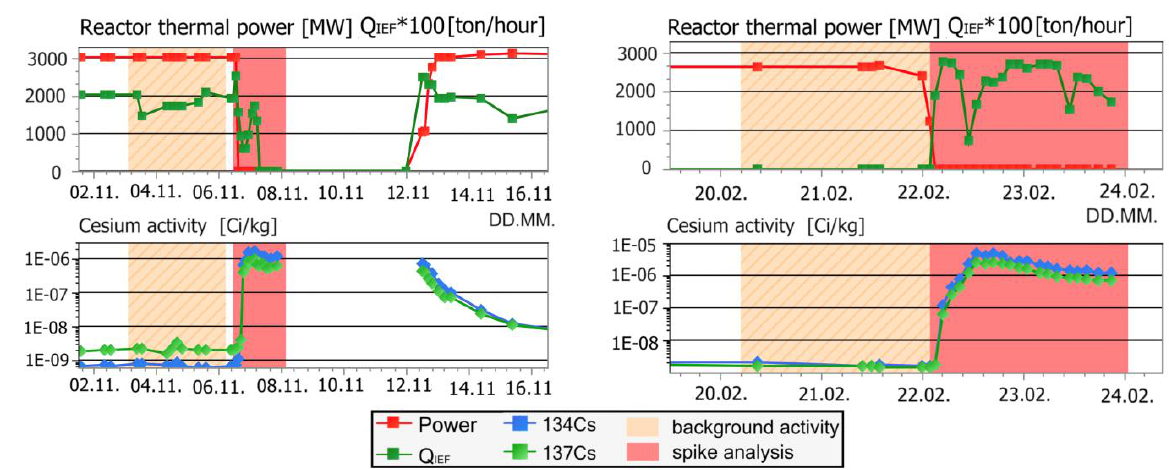
Figure 7. NPP data for caesium activity spike-event in case #3: at interim power drop (left), and after the reactor shutdown (right)